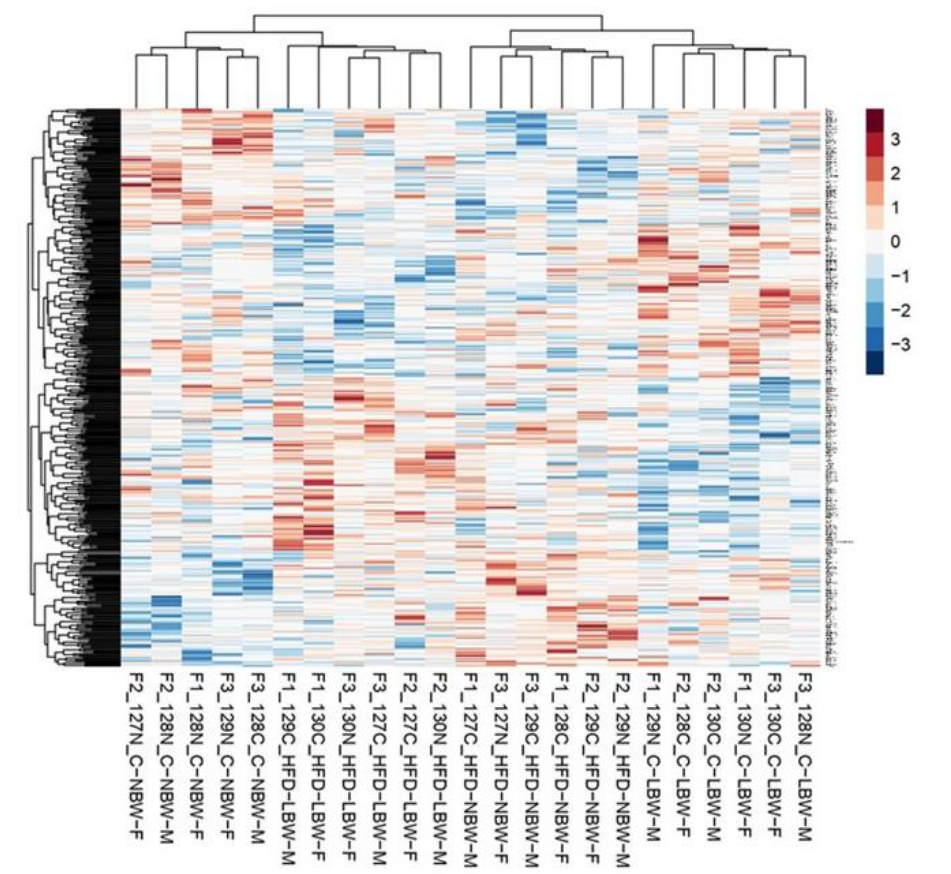
Figure 4. Heatmap of differentially abundant proteins in the hippocampus of pigs in the four analyzed groups (NBW subjected to a control diet (C) or HFD; LBW subjected to a control diet (C) or HFD). Sex of the individual (M, F) is indicated. Numbers indicate the TMT labeling reagent and F indicates the TMT labeling reaction.